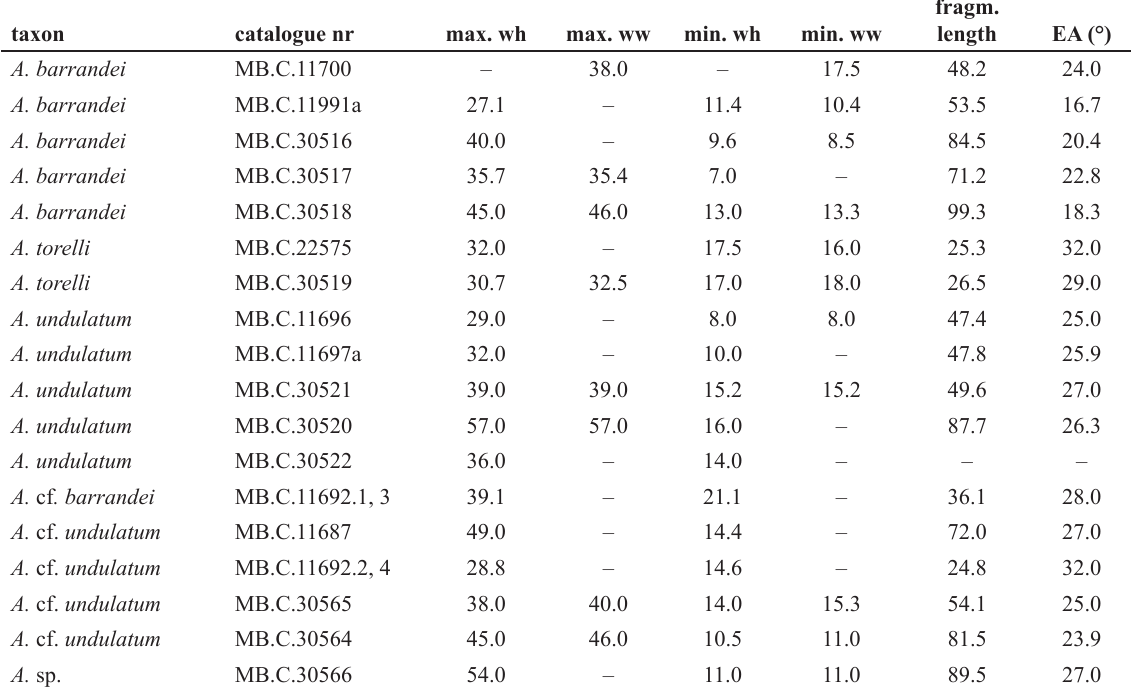
Table 5. Conch measurements (in mm), and expansion rates of uncoiled conch parts of Ancistroceras Boll,